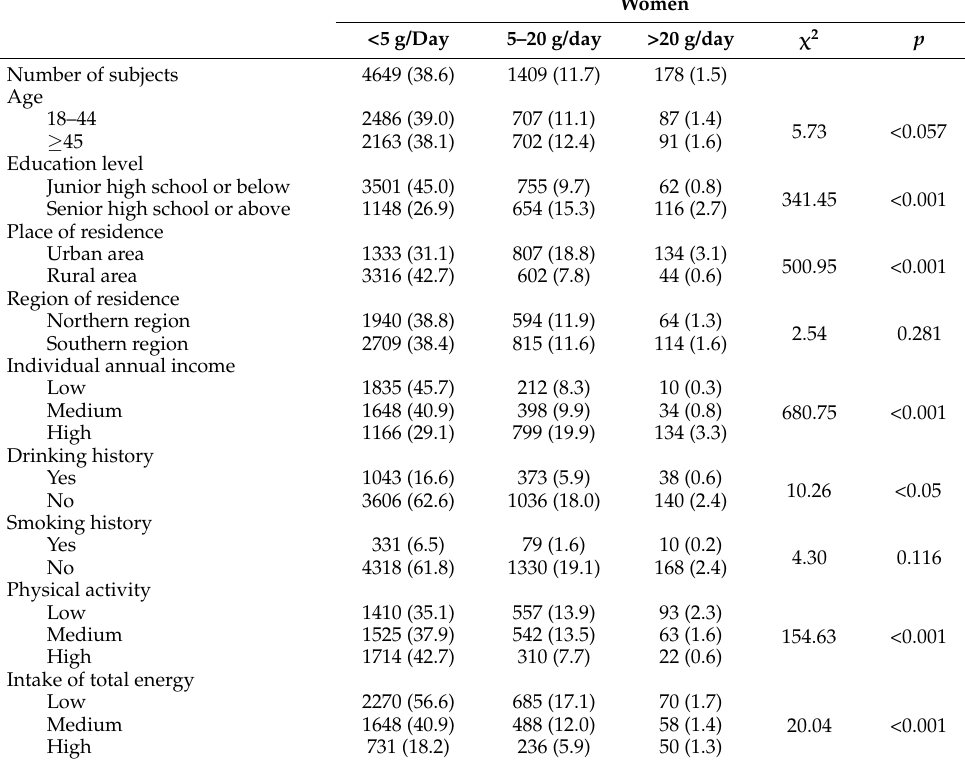
Table 3. Basic characteristics of women according to different levels of free sugars intake,